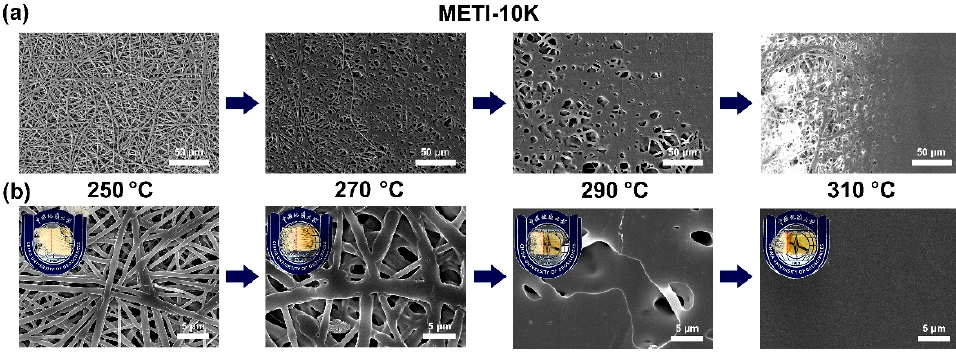
Figure 10. SEM images of METI-10K NFM after hot-pressing treatment. ( a ) 500×; ( b ) 4000×.